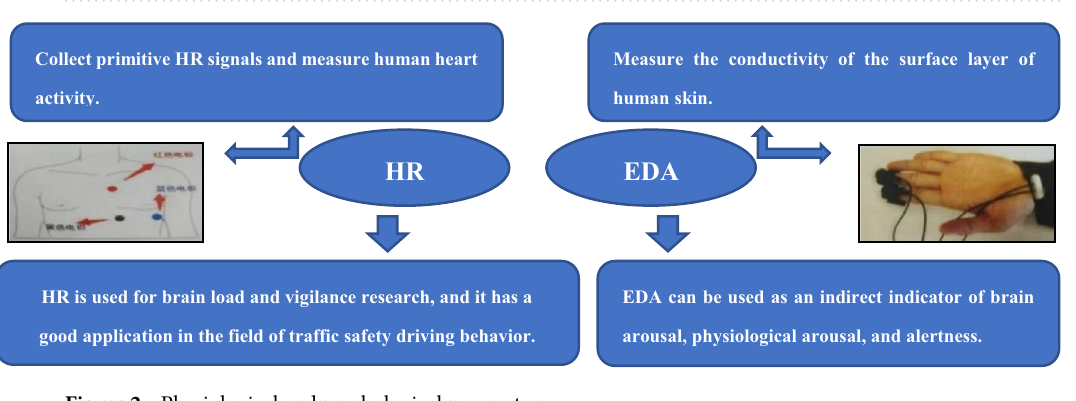
Figure 2. Physiological and psychological